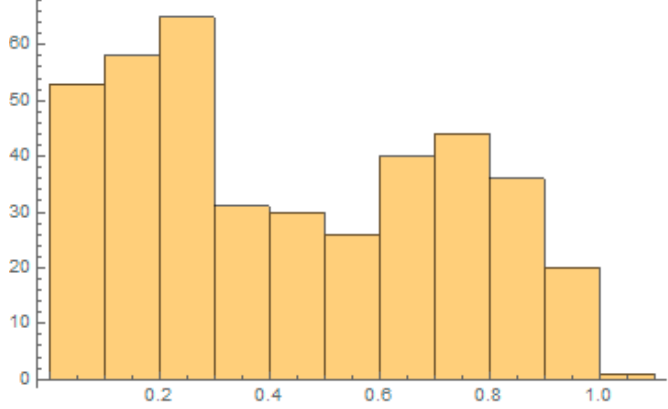
Figure 3. Distribution of historical recovery rates. Data is obtained from Moody’s credit reports and spans the 2005–2017 period. spans the 2005–2017